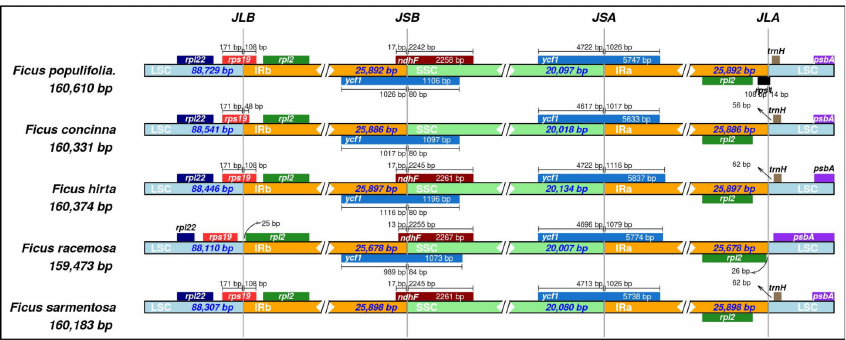
Figure 12. Comparison of boundaries between single copies (SCs) and the inverted repeats (IR) among the five Ficus